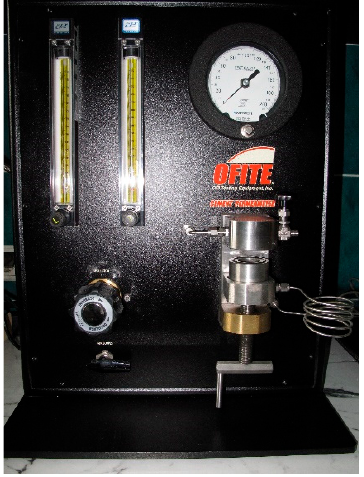
Figure 6. OFITE gas permeability meter.